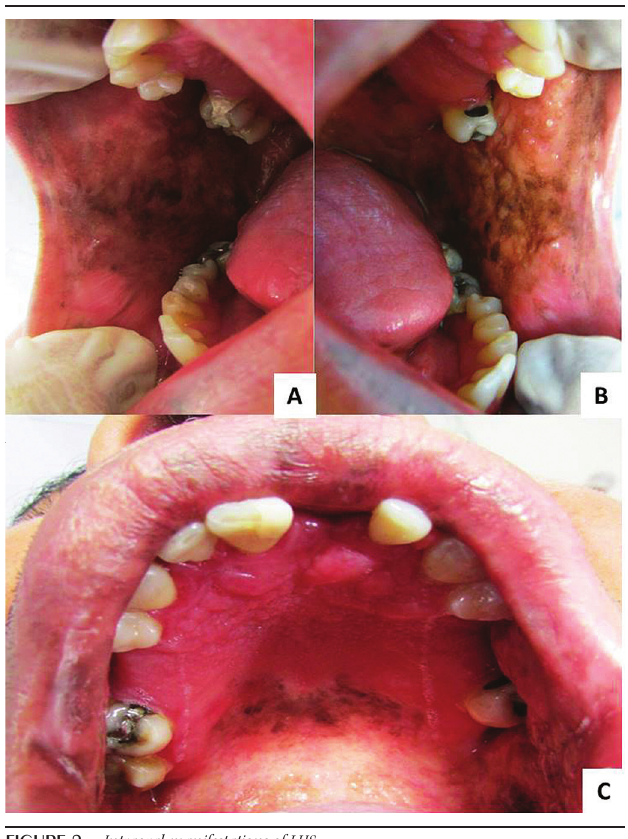
figurE 3 − Histopathological findings displaying mild pigmentary incontinence and other unspecific findings (HE, 400×) HE: hematoxylin and